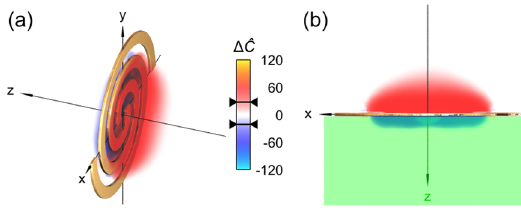
^ ^ ^ C ¼ C þ (cid:3) C (cid:3) of the chirality enhance- FIG. 8. Difference (cid:1) ment of the nanospiral. (a) The side view shows that the distribution of the enhanced regions is continuous, while the structure separates the parts with different signs. (b) In the presence of a substrate, the access is automatically limited to one polarity. Note that this picture is only a sketch, as the calculation was performed without the